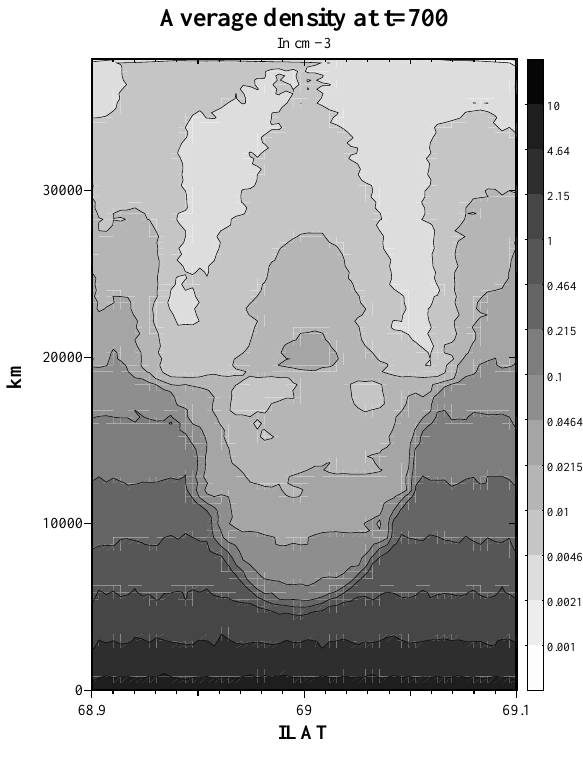
Fig. 4. Density of cold ionospheric ions at t = 700s, averaged over the previous 10s.